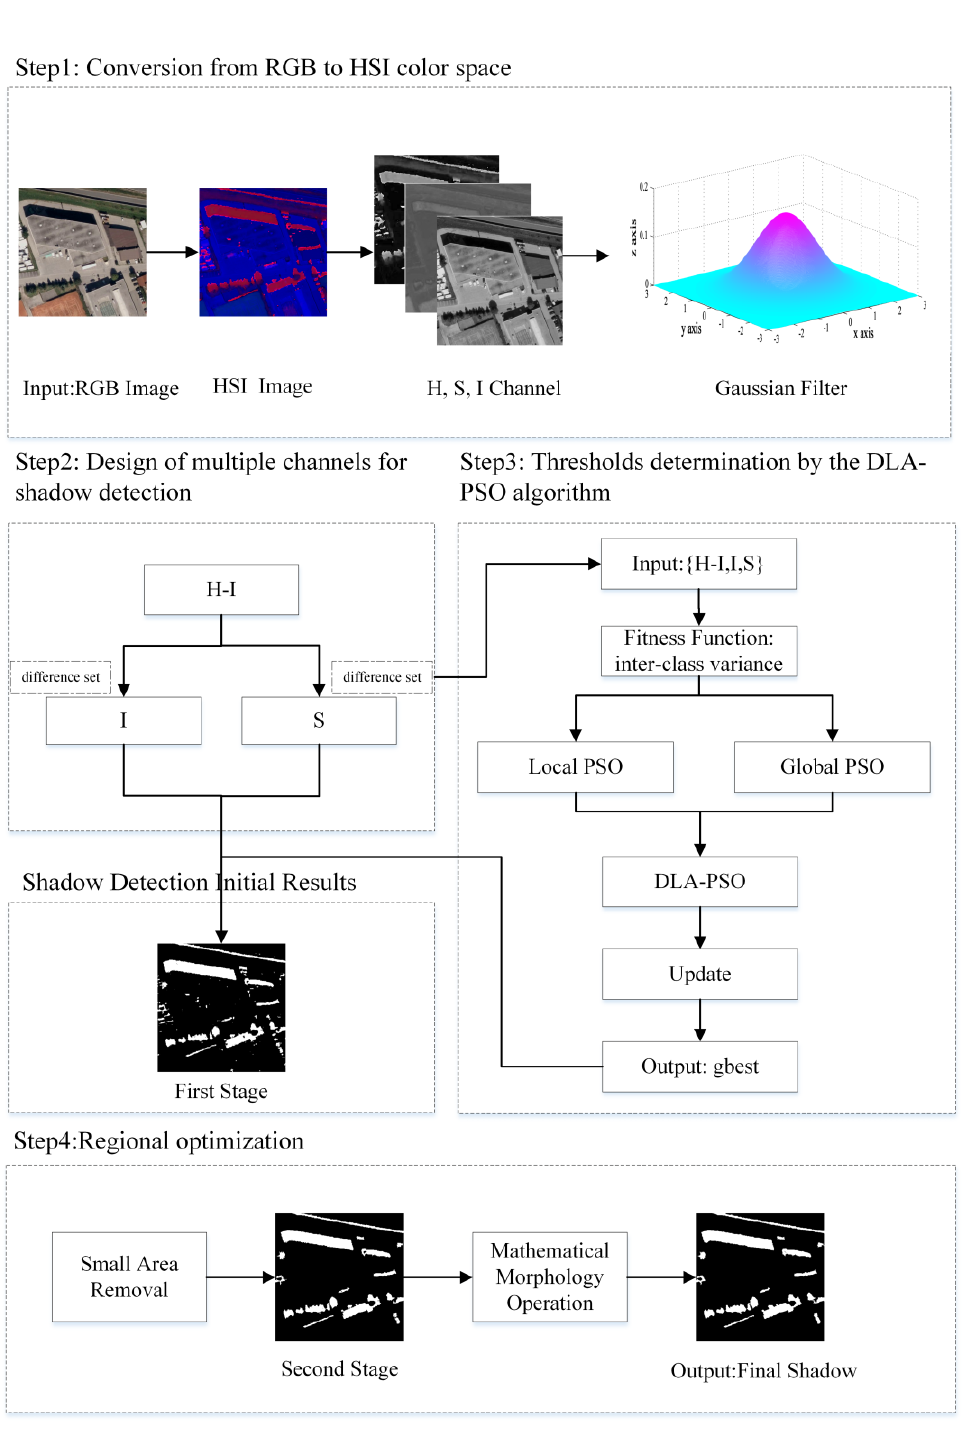
Figure 1. Process of shadow-detection method for remote-sensing images.